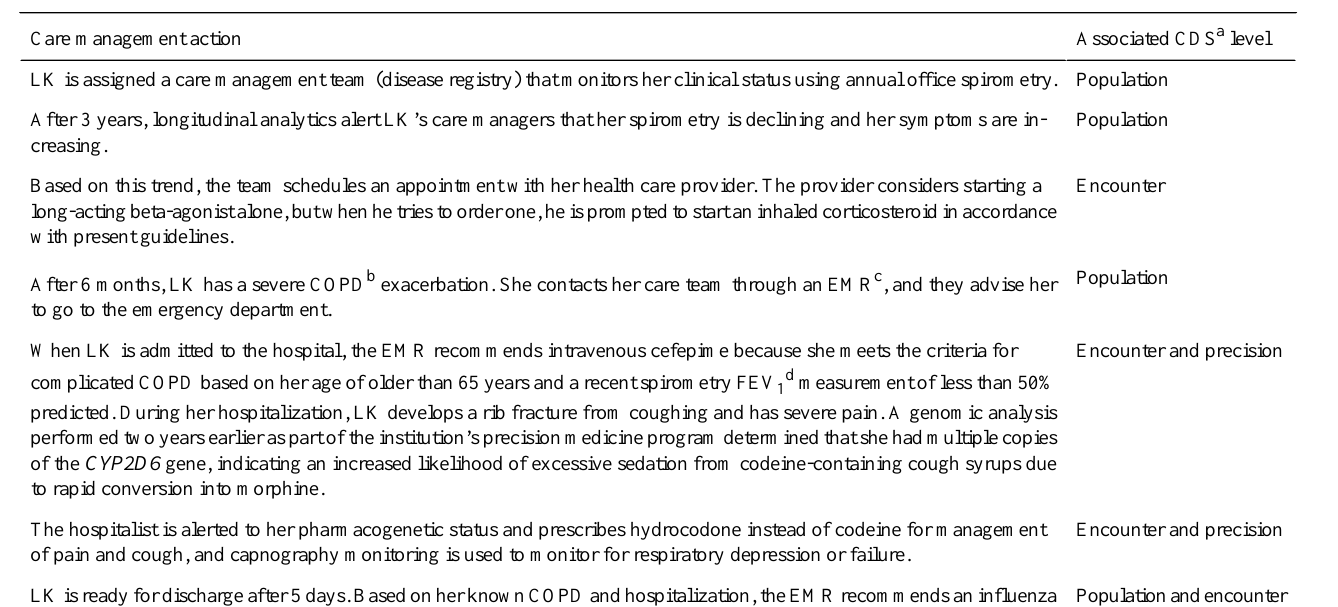
Table 2. Integration of CDS across the population, encounter, and precision care domains of LK, a hypothetical 68-year-old female patient with COPD.